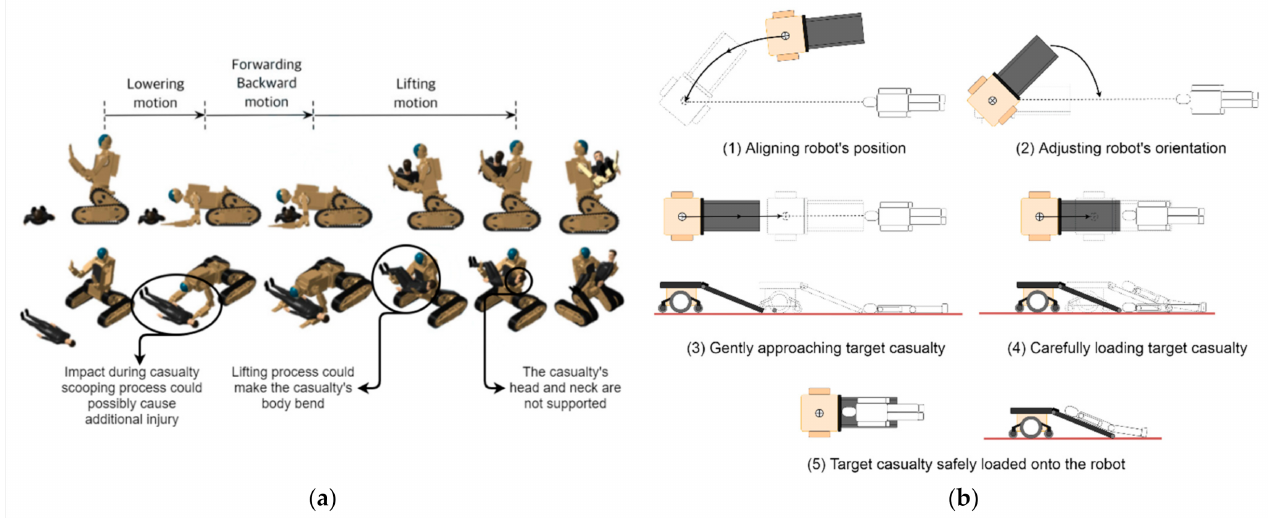
Figure 2. Casualty extraction procedures using two different types of casualty extraction robots. ( a ) Humanoid-type robot construction. The casualty extraction procedure has been presented in [29]. We found that there are at least three safety concerns in the typical humanoid-type robot construction procedure, the impact during the casualty scooping process could possibly bend the casualty’s body sideways, the lifting process could make the casualty’s body bend forward, and provide minimal support for the casualty’s head and neck during the transportation phase. ( b ) Stretcher-type robot construction. The presented casualty extraction procedure introduced as the loco-manipulation approach has been presented in